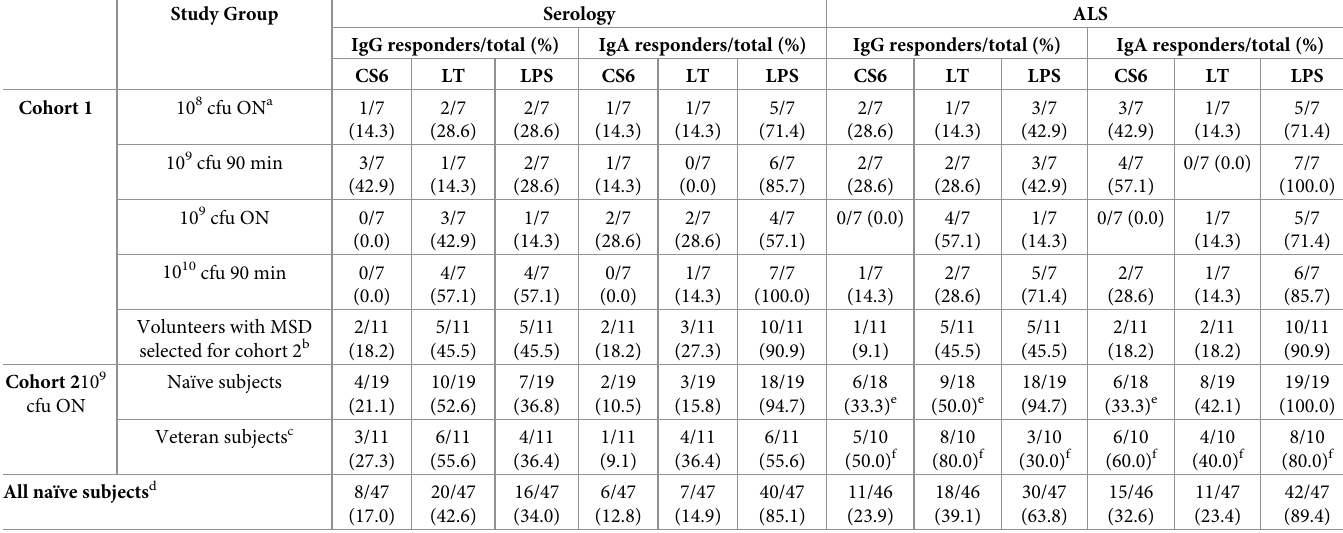
Table 3. Number and percentage of subjects with a response to CS6, LT, and LPS as assessed by serologic and ALS titers. Study